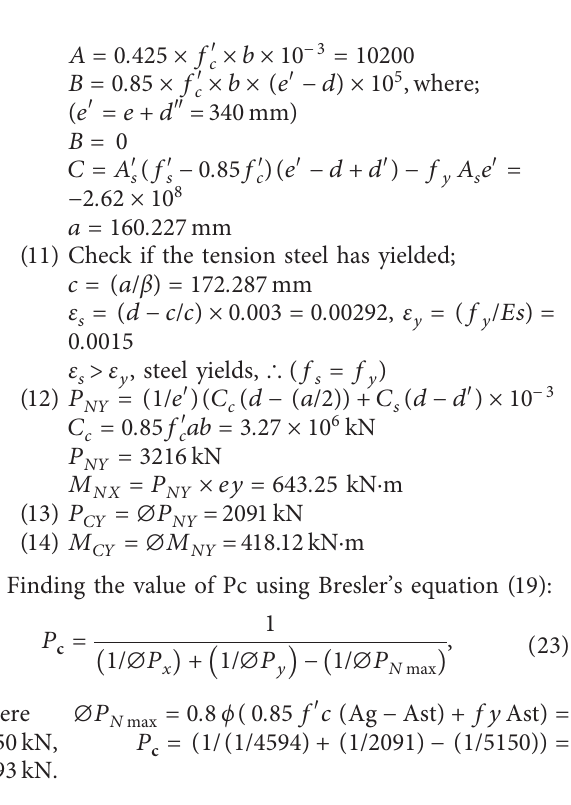
Figure 10: Column CB-7( Y - Y